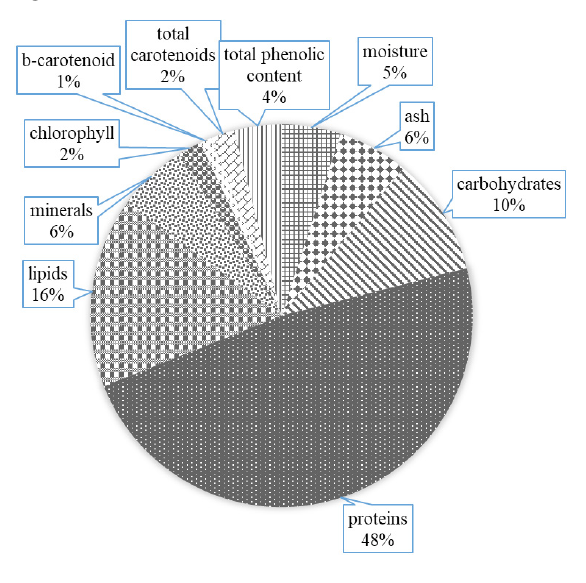
Figure 1: Composition of Chlorella vulgaris (Tokuşoglu and Ünal